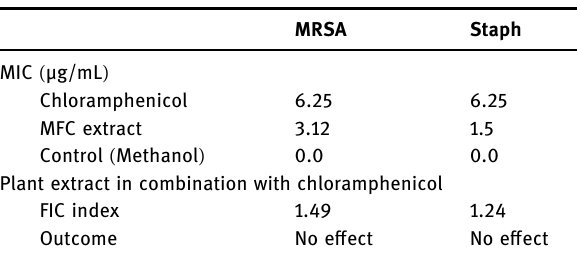
Table 2: Results of MFC extract combination against chloramphenicol